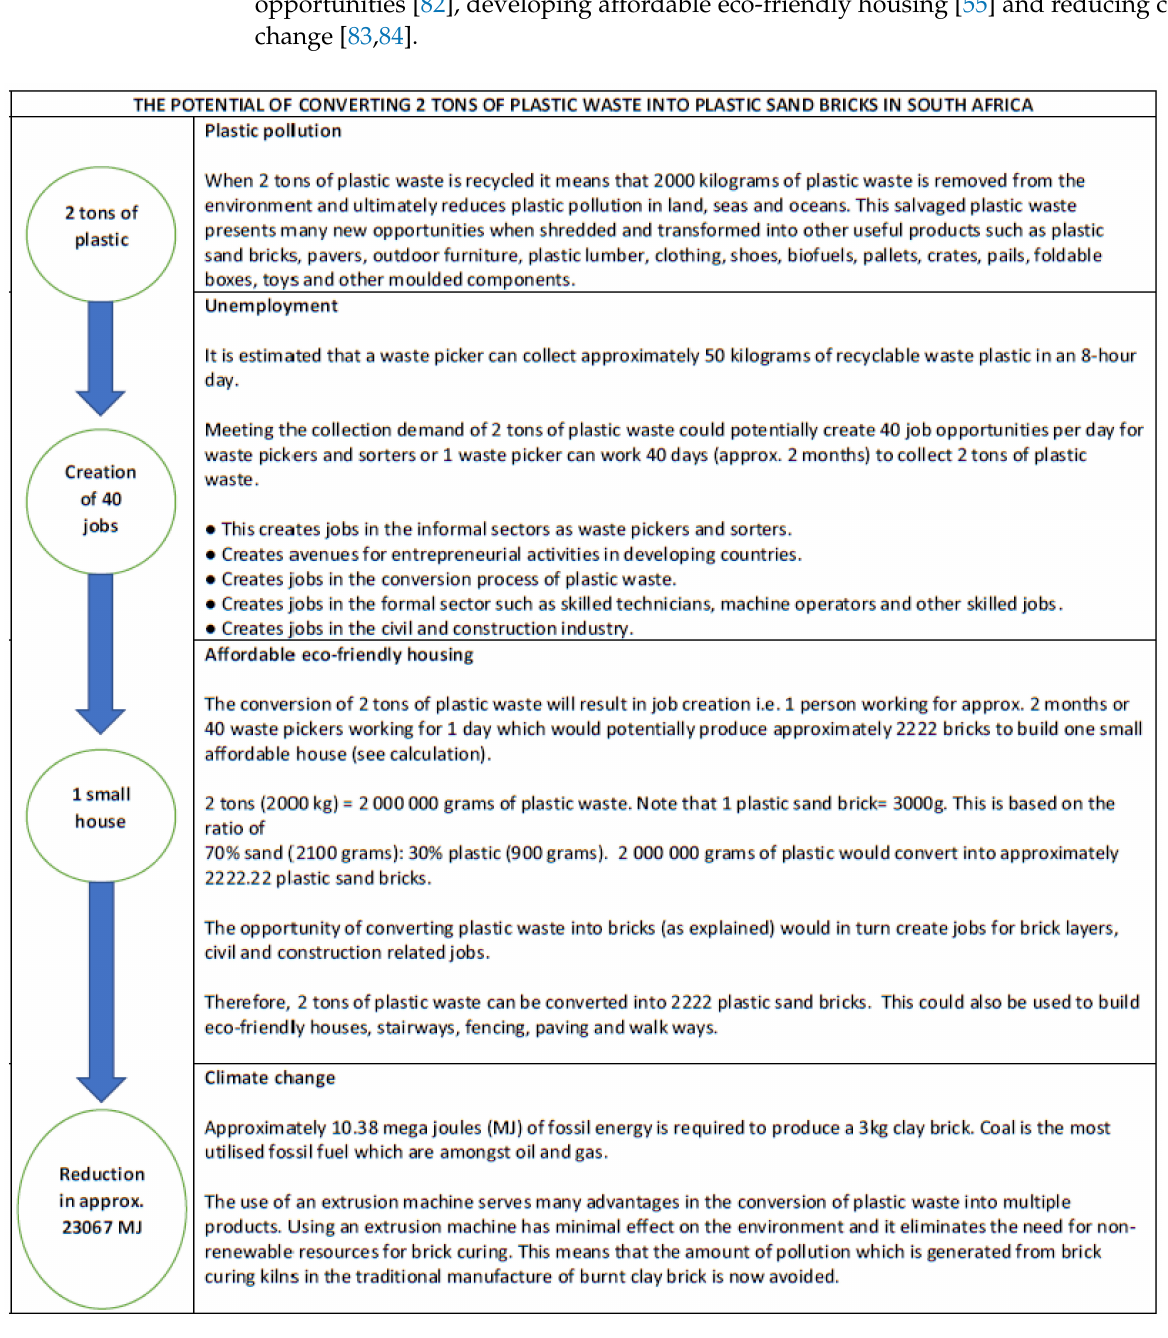
Figure 5. The opportunity of recycling 2 tonnes of plastic from the